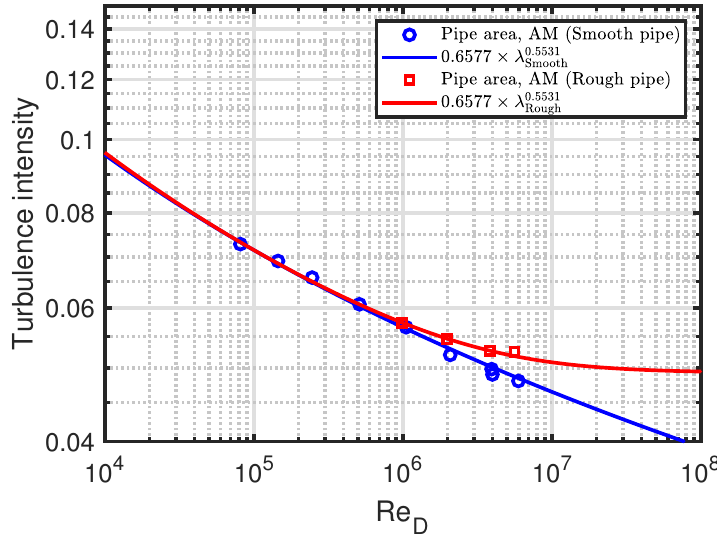
Figure 9. AM definition of TI as a function of Re D for smooth- and rough-wall pipe